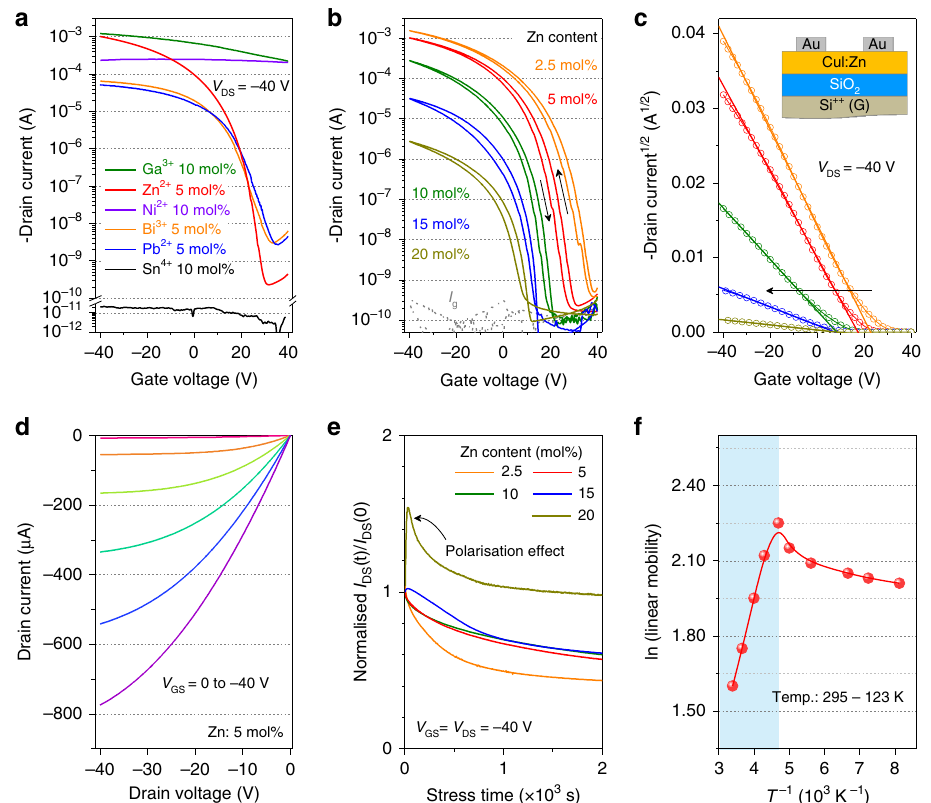
Fig. 3 Electrical performance of doped CuI TFTs. a Optimised transfer characteristics of the CuI TFTs doped with different cations (Ga 3 + , Zn 2 + , Ni 2 + , Bi 3 + , Pb 2 + , and Sn 4 + ). b , c Transfer characteristics and I DS 1/2 curves of CuI:Zn/SiO 2 TFTs with different Zn 2 + -doping contents ( V DS = − 40 V). d Output curves of optimised CuI:Zn 5mol% /SiO 2 TFT. e Negative-bias-stress results of the CuI:Zn/SiO 2 TFTs as a function of Zn 2 + doping content. f Linear mobility variation of the CuI:Zn 5mol% /SiO 2 TFT as a function of the temperature (295 – 123